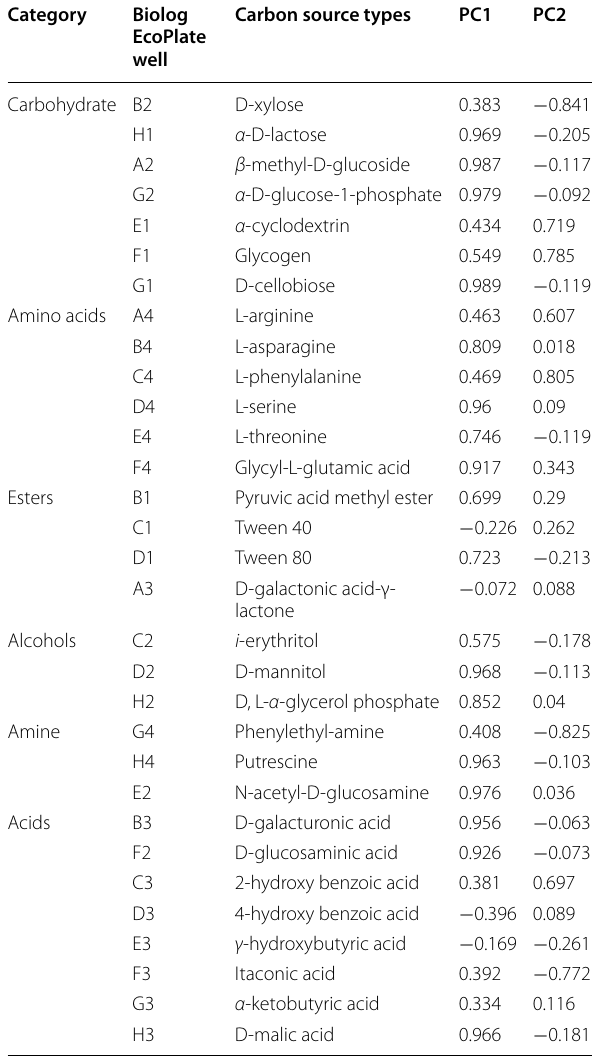
Table 3 Correlation coefficients of major components in 31 kinds of carbon sources